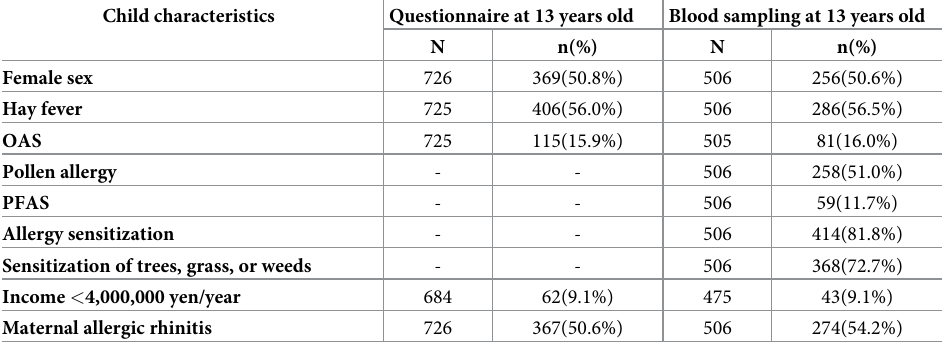
Table 3. Baseline characteristics of participants in this